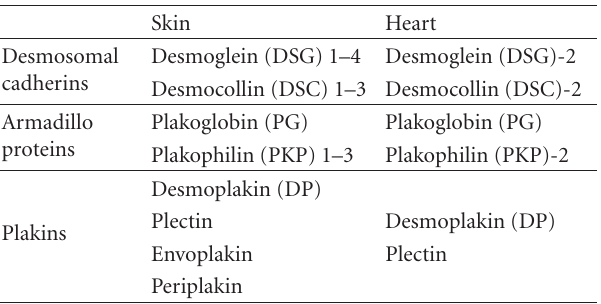
Table 1: The di ff erent composition of desmosomes in skin and